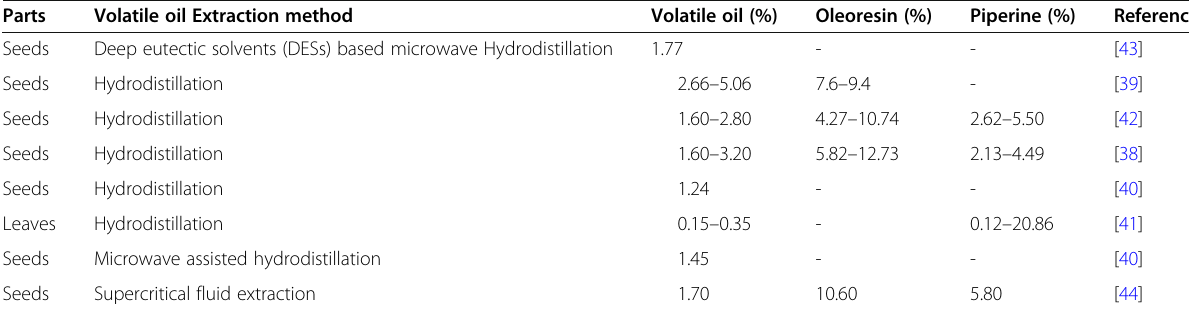
Table 2 Yield of volatile oil, oleoresin and piperine from various parts of black pepper Parts Volatile oil Extraction